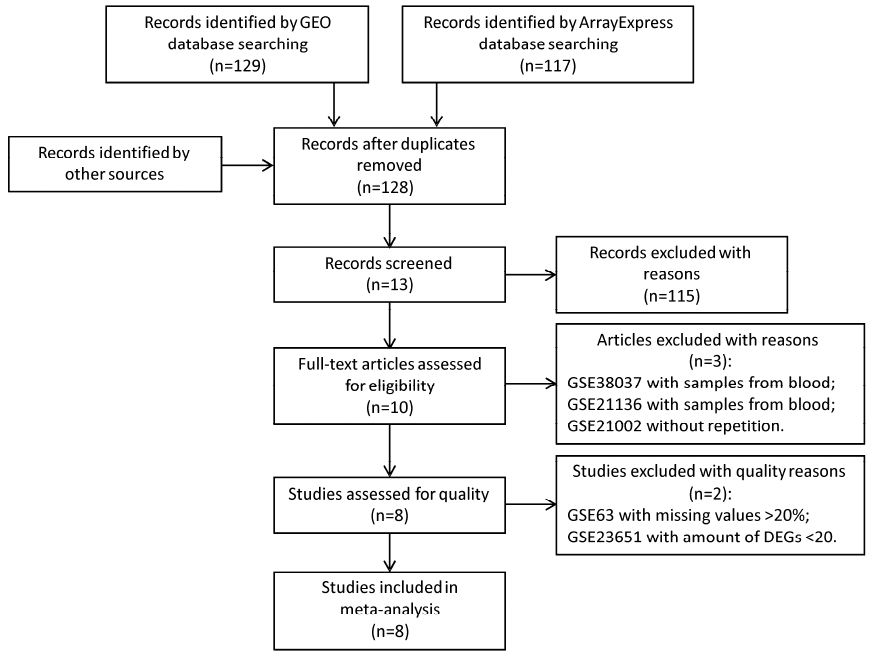
Figure 1. Search in the public microarray data repositories identified 128 microarray datasets.